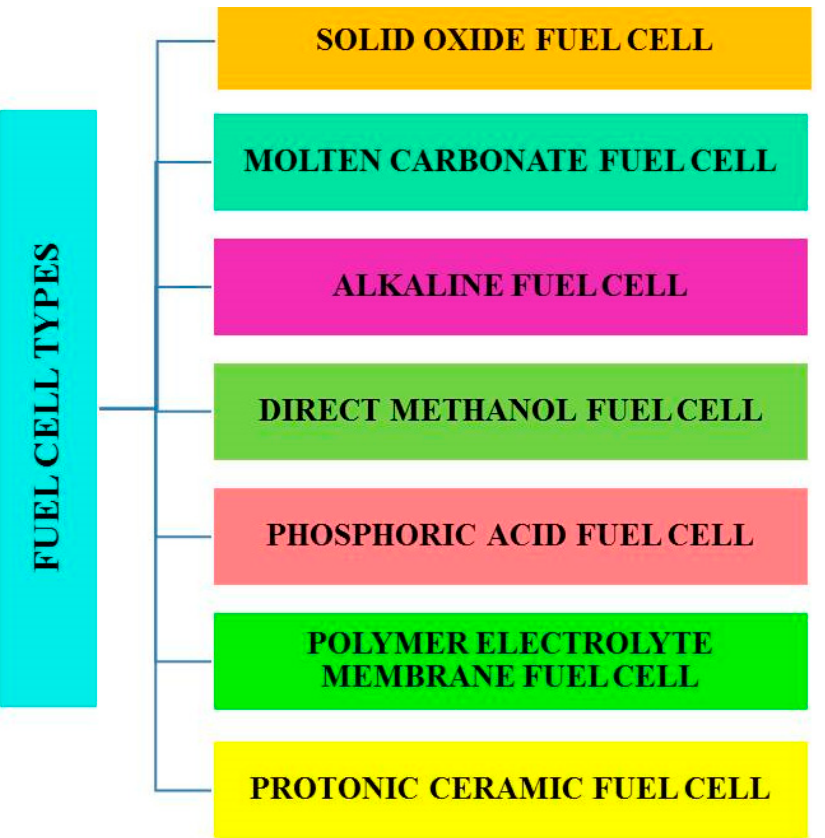
Figure 1. Classification of fuel cells.